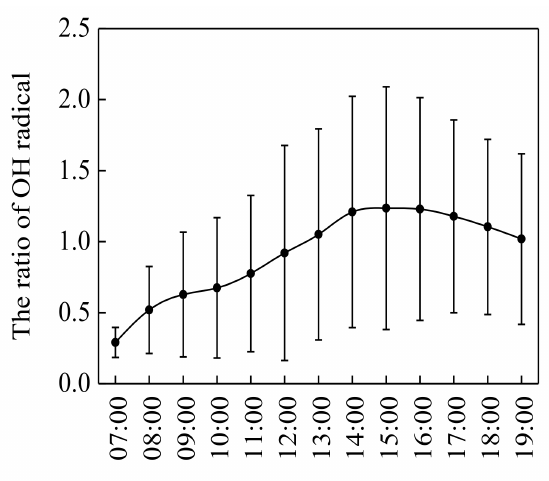
Figure 2. Diurnal variation of OH radical concentration ratios during haze days and non-haze days for the daytime. Table 1. Average mass concentrations ± standard deviation (SD) of 59 VOC species during the observation period at